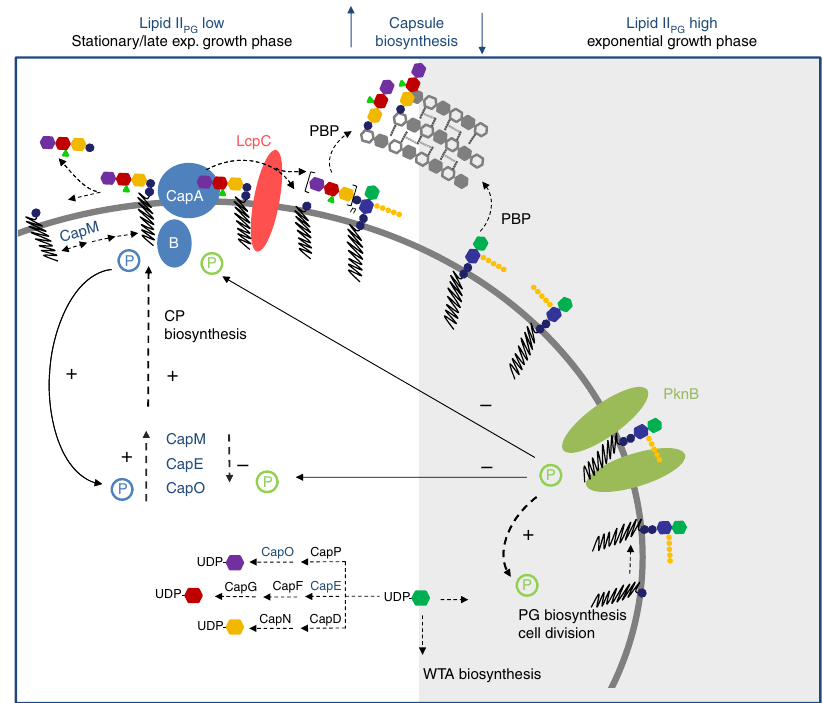
Fig. 7 Model for the regulation of CP biosynthesis and the attachment to PG in S. aureus . The CapA1B1 tyrosine complex (blue) positively controls multiple enzymatic checkpoints to orchestrate CP biosynthesis and precursor consumption during late exponential growth phase (white box). By catalyzing tyrosine phosphorylation (blue ´P´) of biosynthetic enzymes CapE, CapO and CapM, CapA1B1 positively controls the synthesis of both soluble and lipid-linked CP precursors. The membrane-anchored component CapA1 possesses a dual function; CapA1 recognizes lipid-bound CP building blocks and catalyzes the cleavage of the pyrophosphate linkage, releasing the essential isoprenoid lipid carrier C 55 P. CP transfer is catalyzed by LcpC (red), which uses the ultimate peptidoglycan (PG) precursor lipid II PG as an acceptor substrate. During exponential growth phase (grey shading), the insertion of new PG material (LII PG ) into the cell wall network is increased; UDP-GlcNAc and C 55 P are preferably channeled into PG and WTA biosynthesis, while CP production is low. The Ser/Thr kinase PknB (green) contributes to the control of cell wall biosynthesis and cell division. Control of CP formation during ongoing PG synthesis is achieved by PknB via Ser/Thr phosphorylation (green ´P´). PknB negatively controls the activity of the priming glycosyltransferase CapM to regulate